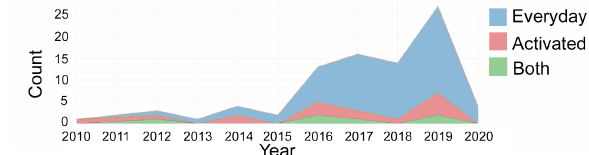
Figure 6. The number of publications with label of